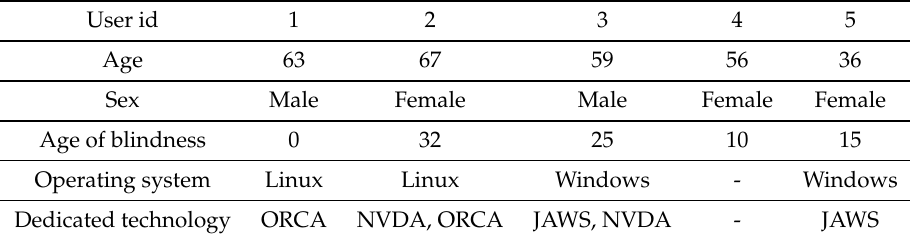
Table 1. Characteristics of the blind population.